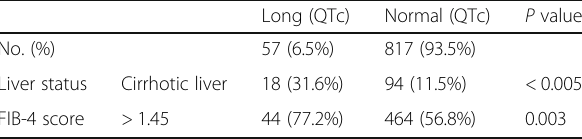
Table 3 Prevalence of long QT interval in cirrhotic patients and in patients with significant fibrosis (FIB-4 ≥ 1.45)